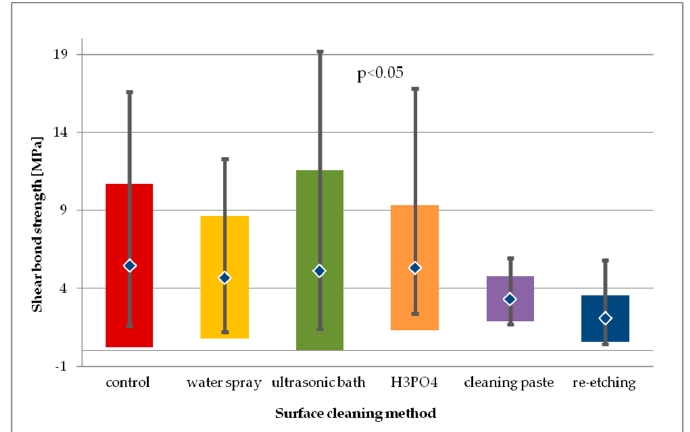
Figure 8. Shear bond strength of resin material to saliva contaminated leucite glass ceramics (LGC) using different cleaning methods, after 24-hour water storage followed by thermocycling. When comparing SBS results for each study group after 24-hour storage and after thermocycling, a statistically significant decrease in SBS values was observed for the following cleaning methods: water spray ( p < 0.01), cleaning paste ( p < 0.01), re-etching ( p < 0.001), ultrasonic